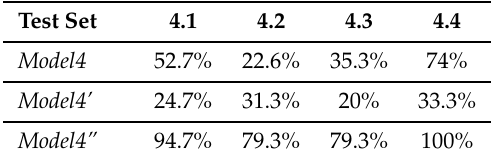
Table 6. Classification accuracies of the models on six